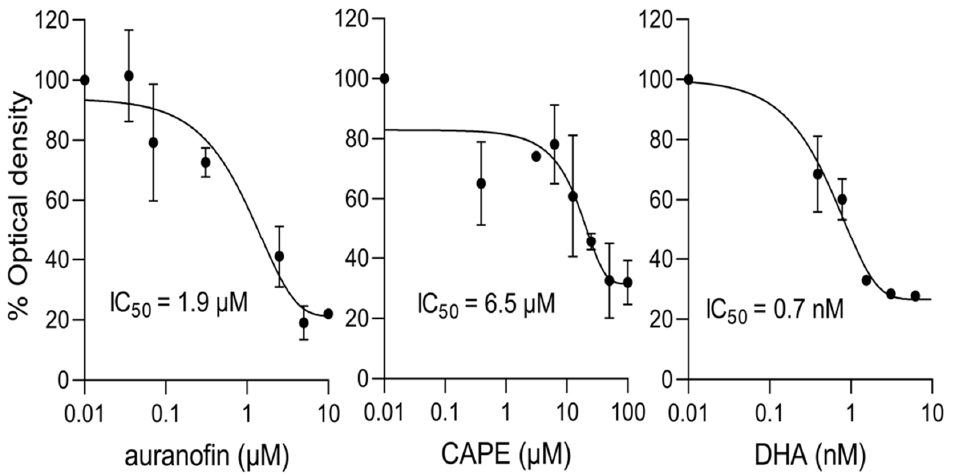
Figure 6. Auranofin and CAPE inhibit P. falciparum parasites grown in culture at low µM concentrations. P. falciparum cultures (0.25% parasitemia) were treated with increasing concentrations of the indicated compounds for 72 h, after which the HRP2-based sandwich ELISA was used to measure the HRP2 levels, determined by optical density. Results shown are from a single typical experiment performed in duplicate (SD shown), representative of a series of three independent experiments (see Table 3 for pooled data).